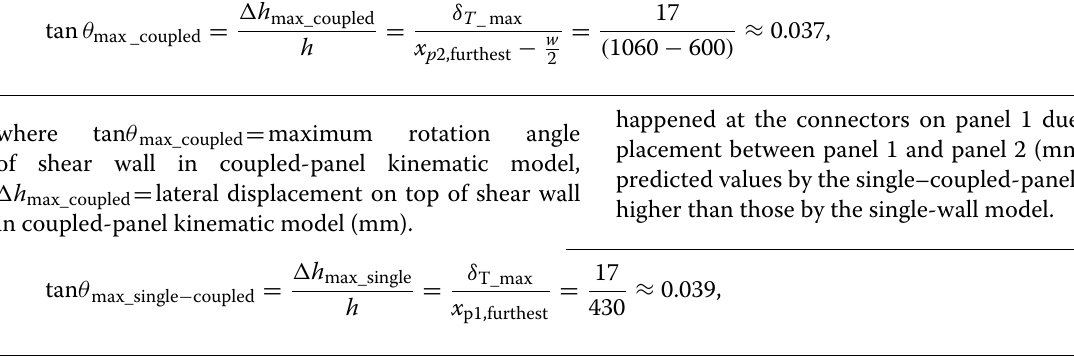
For the coupled-panel model, if the vertical connectors (Fig. 3b) have the same shear resistances ( R s in Fig. 3b), the reaction force at the rotation point ( R B ) of panel 2 increases as much as the tensile resistance increased by the wall-to-floor connectors of panel 2. Thus, when the same number of wall-to-wall connectors were used (W2_ F2_24kN, W2_F4_24kN), the predicted lateral resistance by the coupled-wall model was the same as 17.8 kN. For the coupled-panel model, if the shear resistance of the vertical connector is the same, the reaction force at the rotation point of panel 2 increase as much as ten- sile resistance increase by the wall-to-floor connectors on panel 2. Thus, when the same number of wall-to-wall connectors was used (W2_F2_24kN, W2_F4_24kN), the two predicted lateral resistances by the coupled-wall model were the same as 17.8 kN. Figure 13 is a graph of the tested and predicted values in Table 4. The seven shear wall specimens was consisted of different combination of wall-to-wall connectors and wall-to-floor connectors. The lateral resistances